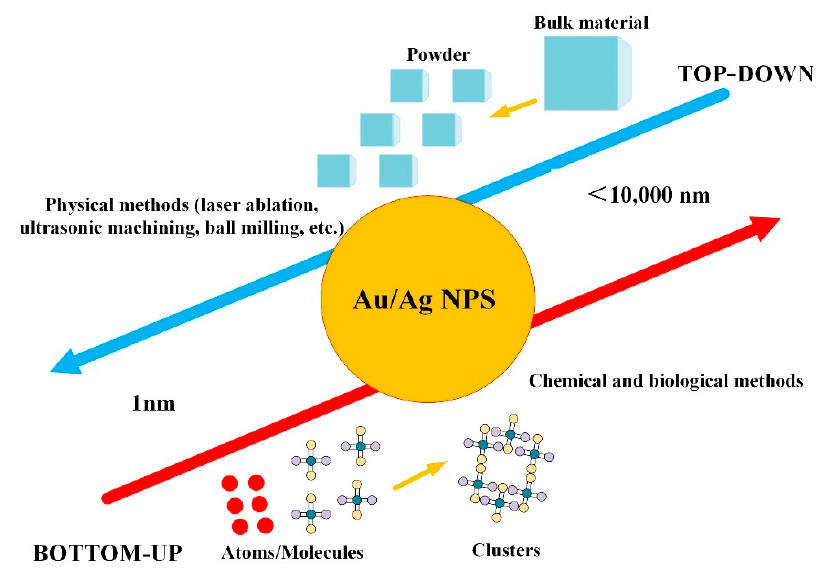
Figure 2. Two different methods to fabricate Au/Ag NPs: top-down and bottom-up.